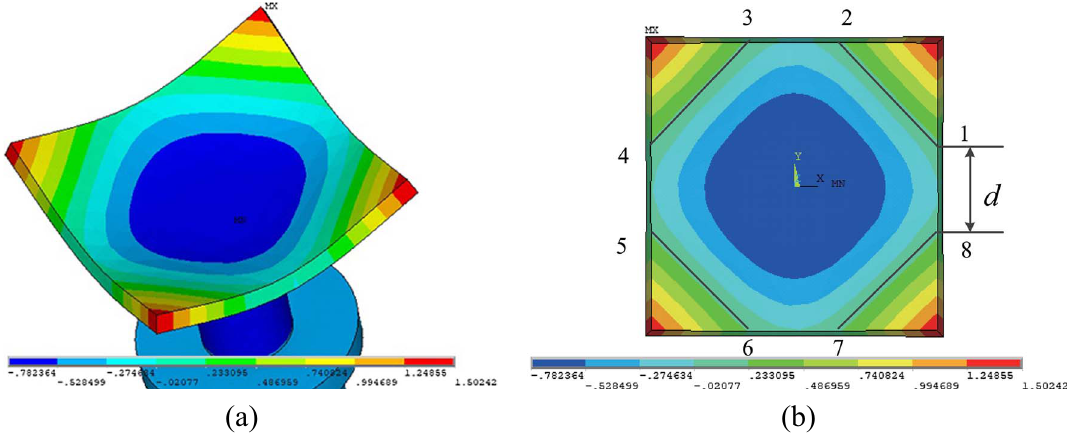
Figure 3. A response vibration mode obtained at 19,006 Hz by driving center of the SFPR with a longitudinal vibration transducer. (a) The response vibration mode, (b) position of the four straight nodal